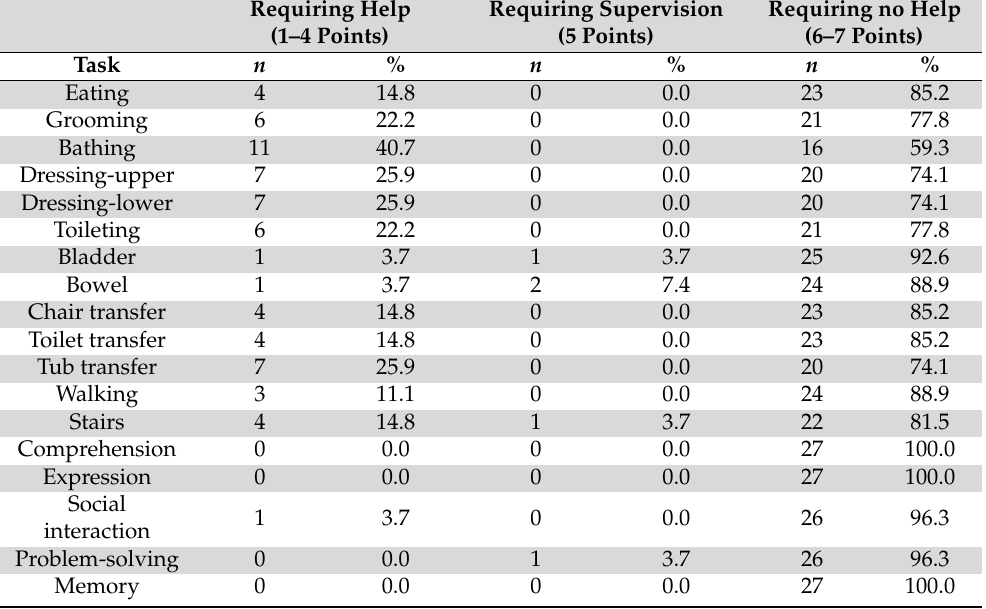
Table 5. Scores of individual WeeFIM tasks grouped into help, supervision, and no help